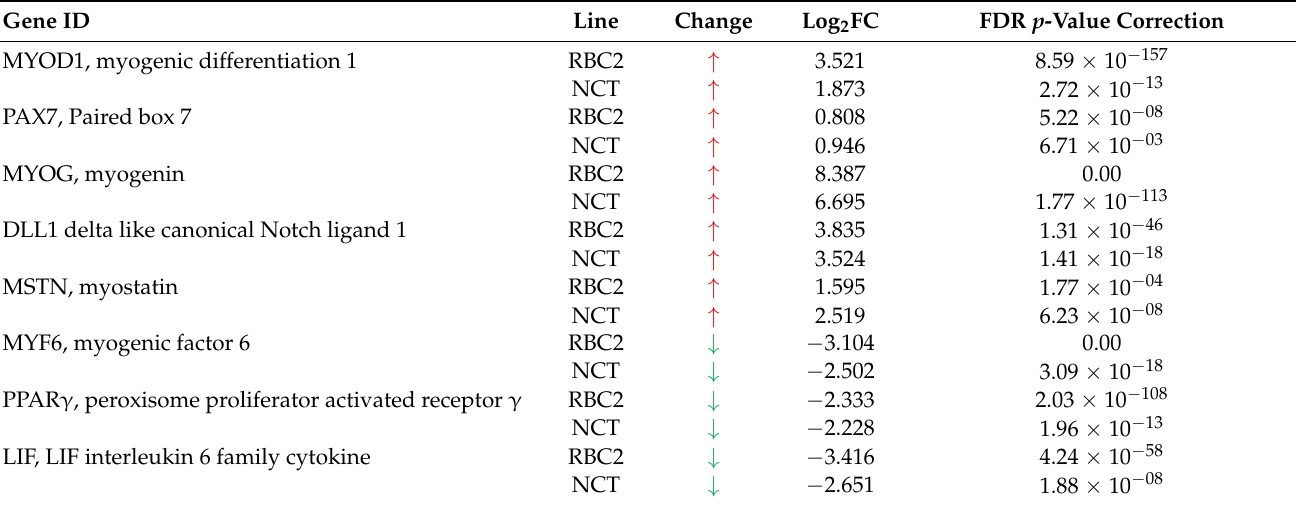
Table 3. Differential expression of skeletal muscle marker genes in SCs following 48 h of differenti- ation at 38 °C compared to 72 h of proliferation [26]. For each gene, the directional change in gene expression between differentiating and proliferating cells, the fold change (Log 2 FC) and False Dis- covery Rate (FDR) p -value are given for the comparisons within each turkey line (RBC2 and NCT). Directional expression of genes is indicated by red (up) or green (down).